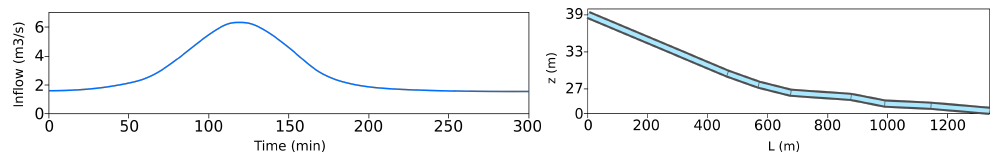
Figure 3. Case 1: Inflow hydrograph applied at upstream end of culvert ( left ). Culvert profile geometry ( right ). z refers to the pipe elevation over el outlet point.